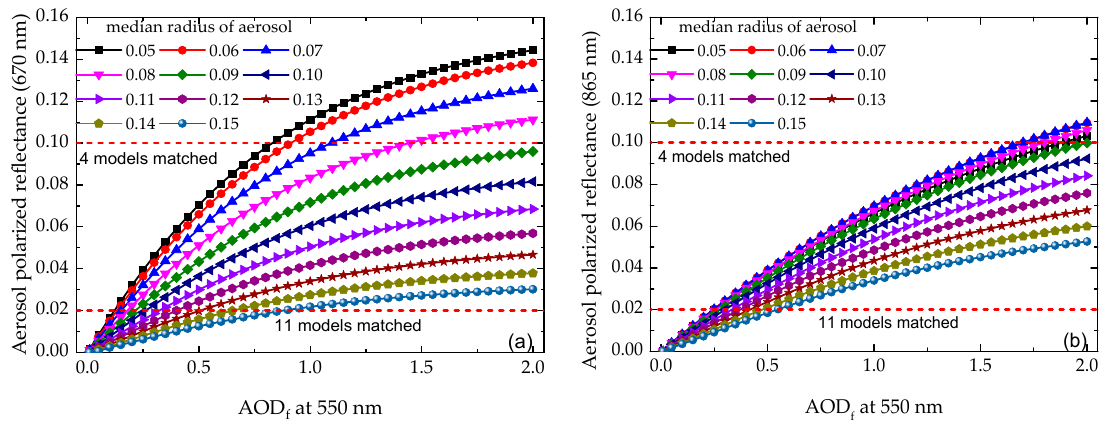
Figure 2. Variations of aerosol polarized reflectance versus AOD f for the fine-mode aerosol models in PARASOL operational algorithm. ( a ) aerosol polarized reflectance (670 nm), ( b ) aerosol polarized reflectance (865